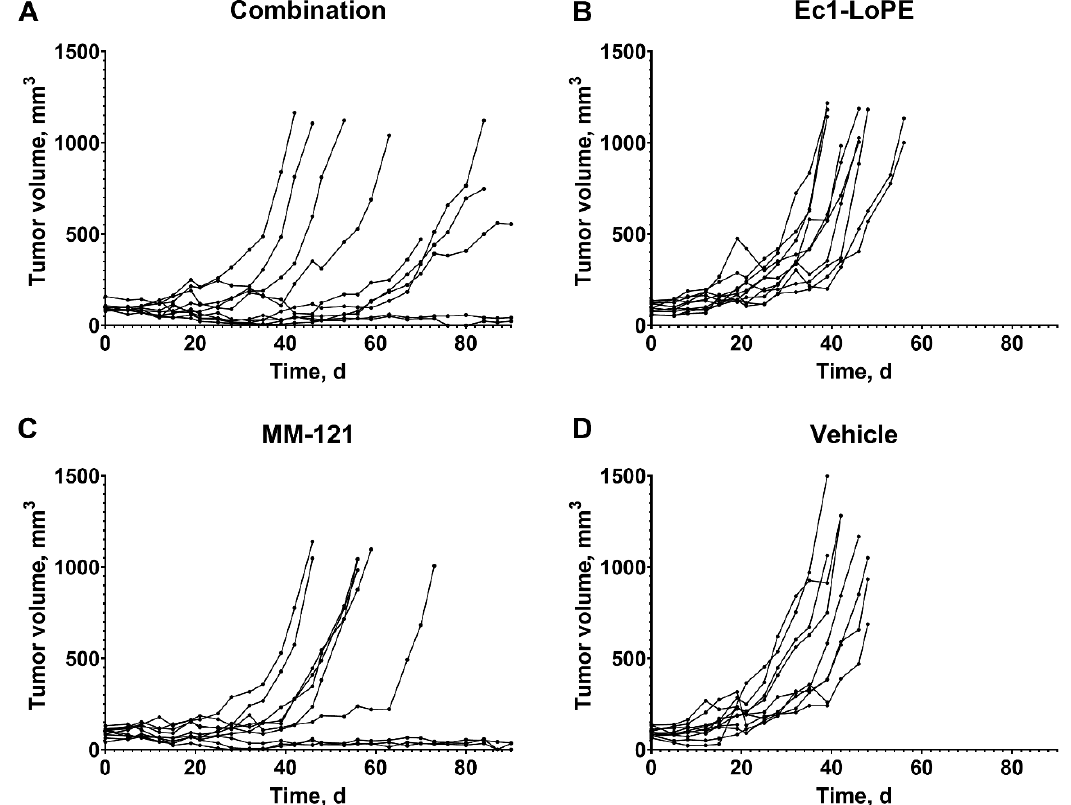
Figure 6. Individual tumor volume growth curves in BALB/c nu/nu mice bearing BxPC3 xenografts from four groups receiving: ( A ) intravenous (i.v.) injections of Ec1–LoPE and intraperitoneal (i.p.) injections of MM-121; ( B ) i.v. injections of Ec1–LoPE; ( C ) i.p. injections of MM-121; and ( D ) i.v. injections of vehicle (0.9% NaCl). Mice were euthanized when the xenograft volume exceeded 1000 mm 3 , bleeding ulcers on xenografts were observed, or over 10% weight loss was detected within one week.